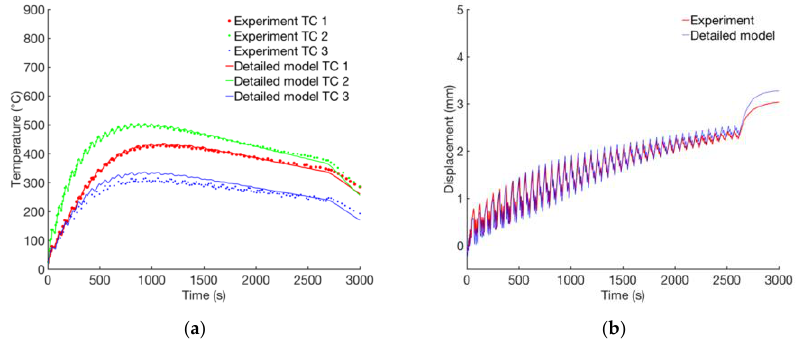
Figure 9. Temperatures ( a ) and displacements ( b ) from measurements and model with fine mesh and no dwell time between layers.